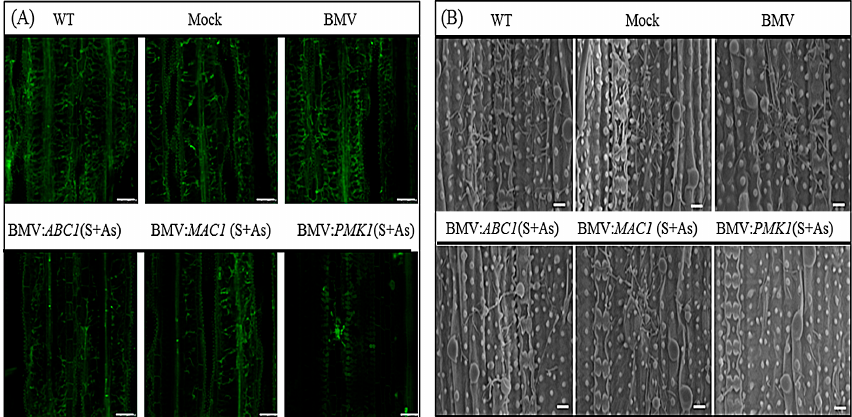
10 µ m. ( B ) Under a scanning electron microscope (SEM), fungal development in rice leaves inoculated with BMV variants were observed. Scale bars are 50 µ